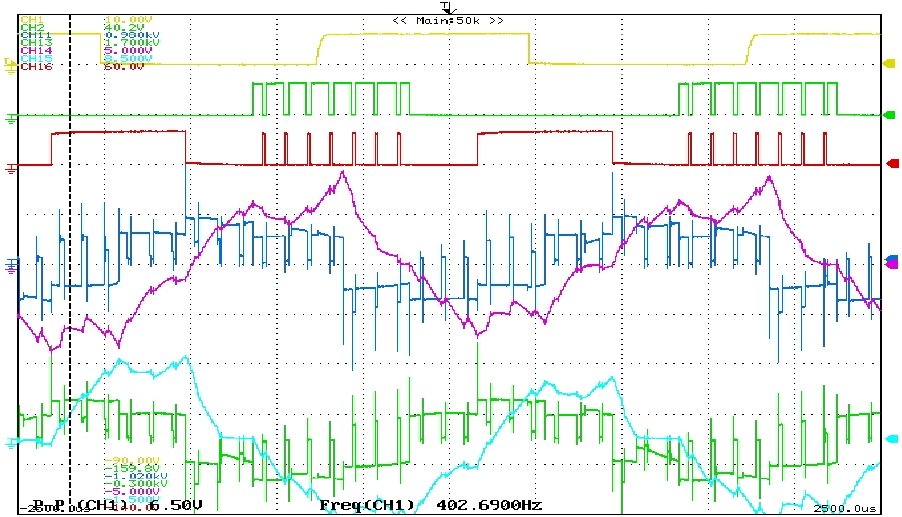
Figure 17. Phase voltages, and phase currents overlap with the respective PWMs Vs time at full Load.